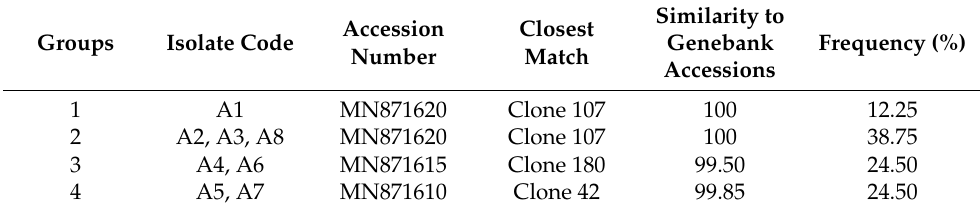
Table 2. Molecular variability of A. solani